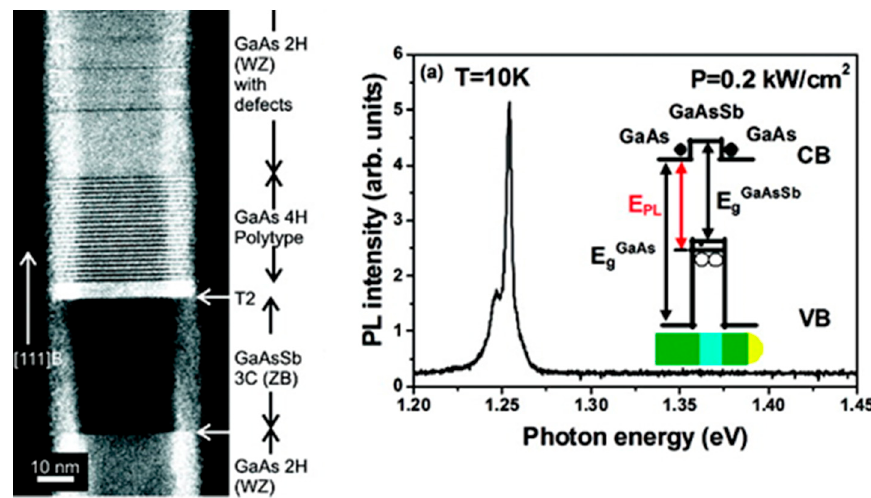
Figure 15. ( a ) TEM images of the GaAs/GaAsSb NWs and ( b ) low temperature PL spectrum of a single GaAs/GaAsSb NW. Reproduced with permission from [88], copyright American Chemical Society (2010).